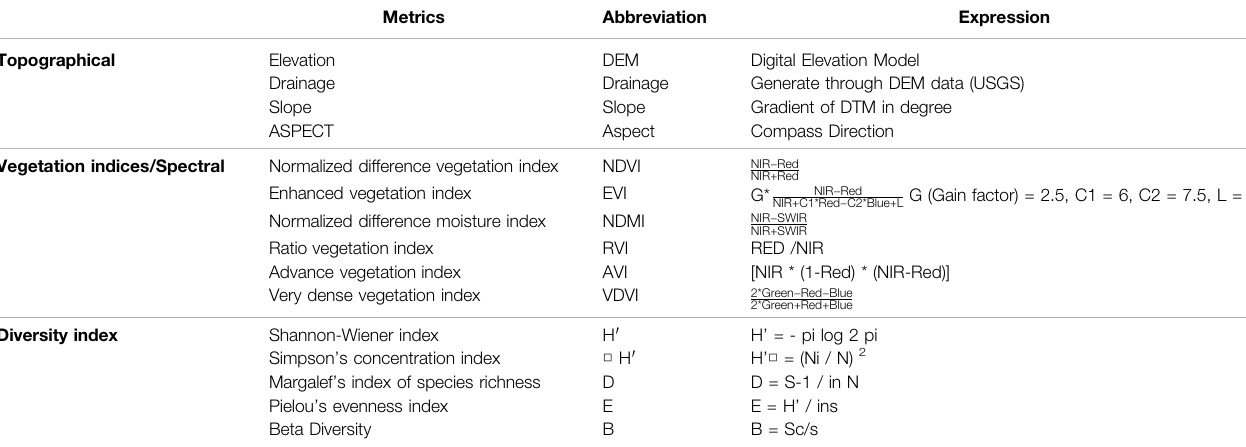
TABLE 1 | Topographical, vegetation indices/spectral and diversity